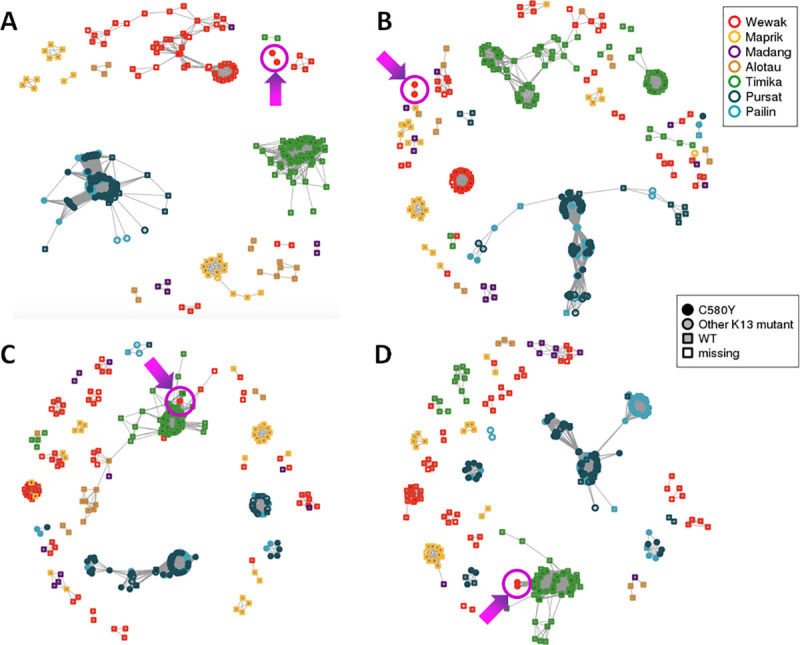
IDB-based clustering.These isoRelate network plots show IBD relationships between all samples analyzed for different genomic regions. Wewak C580Y mutants are shown by a magenta circle, pointed to by an arrow; note that only two mutants were included in this analysis, due to high degree of genotype missingness in the third mutant. (A) Whole-genome IBD shows that, although most parasites cluster strongly by geography, the C580Y mutants form a separate group, probably reflecting their admixed structure. (B) IBD in chromosome 13 regions flanking the kelch13 gene shows that Wewak parasites do not cluster in a single group, and the C580Y mutants form a group on their own; no New Guinea parasites cluster with the Cambodian group, confirming that kelch13 haplotypes on the island have independent origin. (C) IBD in chromosome 10 regions flanking the atg18 gene shows that C580Y mutants cluster with the Timika samples, as is also the case in the chromosome 5 regions flanking the pnp gene (D). In B-D, flanking regions are 75 kbp regions on either flank.